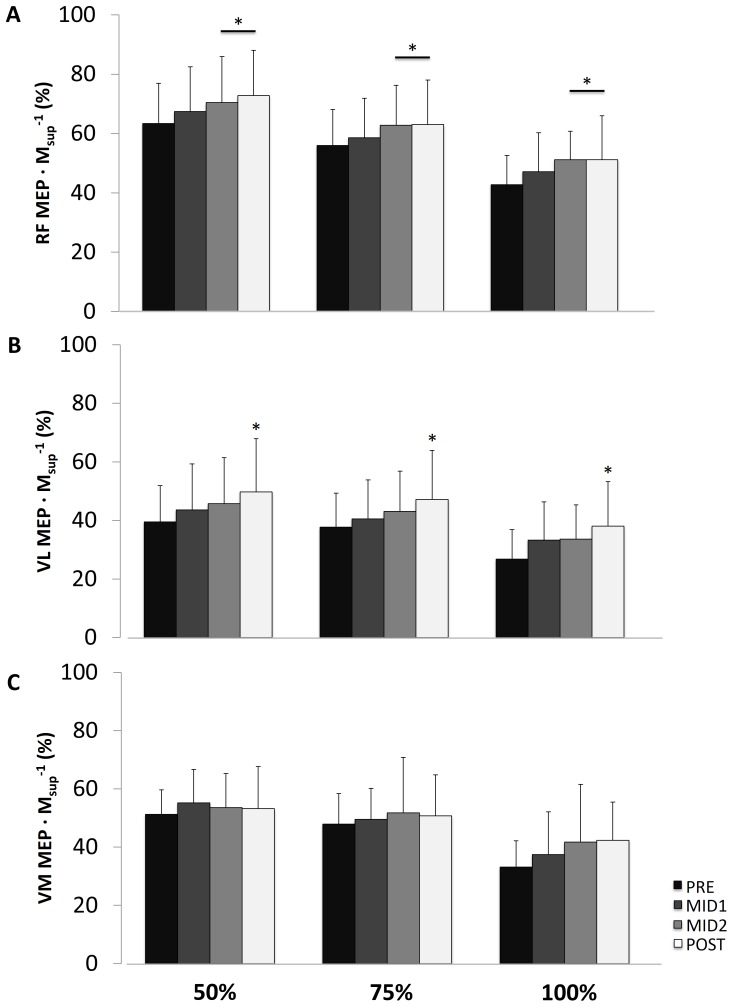
Motor-evoked potential normalized to maximal M-wave amplitude (MEP·Msup
−1) at 50, 75 and 100% of maximal voluntary contraction level for rectus femoris (RF, panel A), vastus lateralis (VL, panel B) and vastus medialis (VM, panel C) before (PRE), after 80 min (MID1) and 160 min (MID2) of cycling and after the 4-h cycling exercise (POST).Significantly different from PRE: *P<0.05.